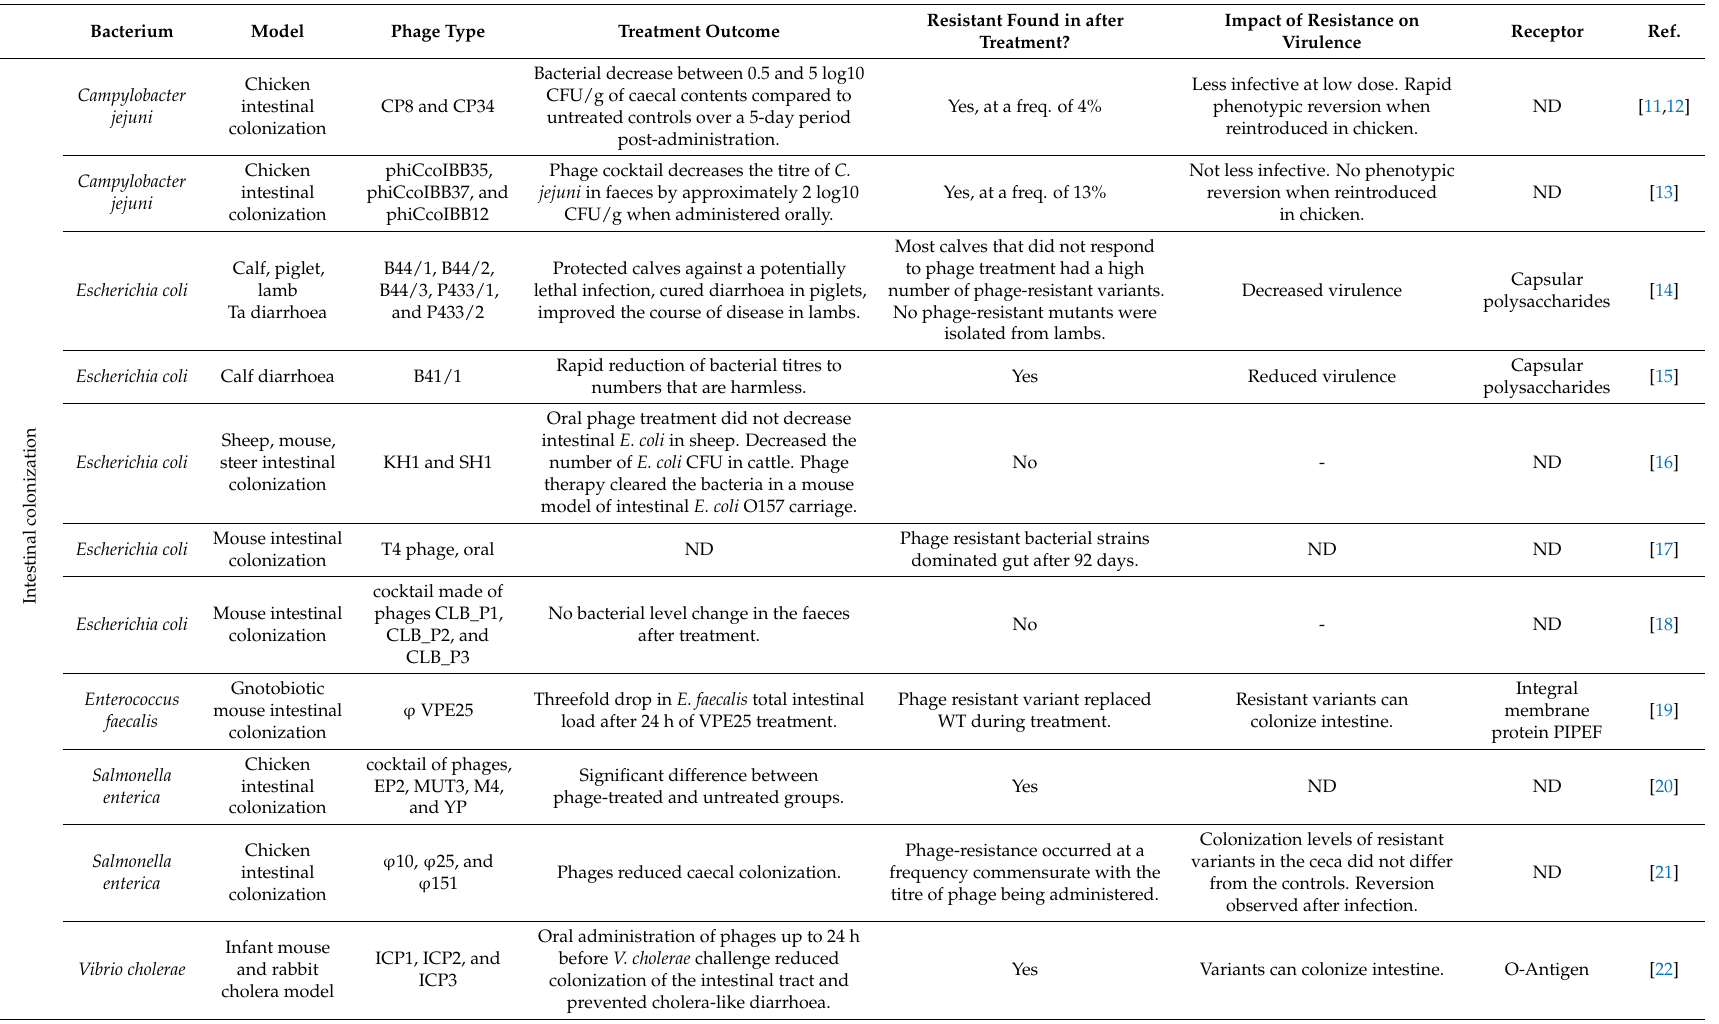
Table 1. Principal in vivo studies investigating the relation between phage therapy and phage